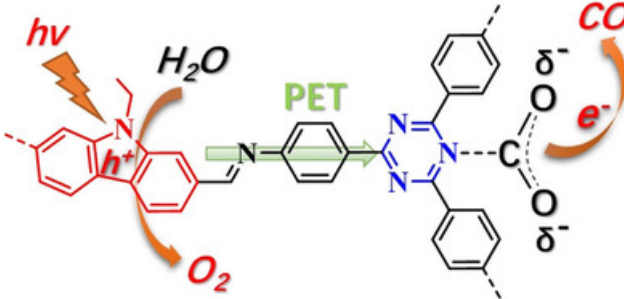
Figure 10. Proposed photoactive electron transfer and reaction pathway in the photoreduction of CO 2 (PET = photoinduced electron transfer). Copied with permission from Wiley 2019 [39].